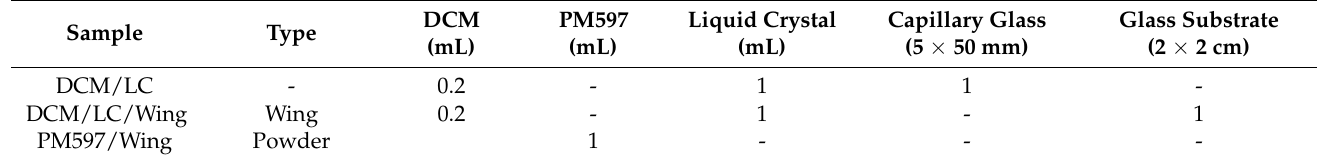
Table 1. The samples and their components used in the experiment.